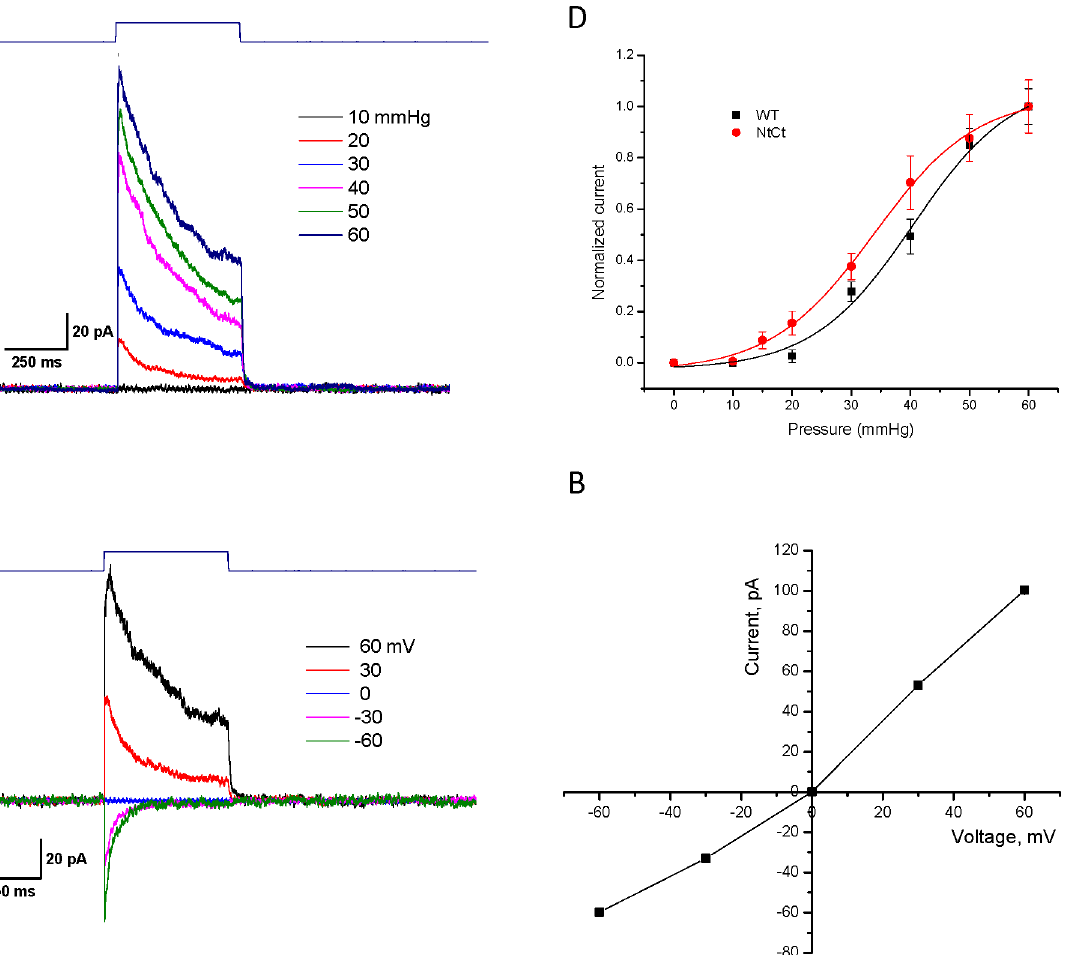
Fig 4. PIEZO1 split protein produces currents from outside-out patches. Panel A show that by increasing pressure on outside-out patches is correlated with increasing current. Panel B is a Boltzmann plot of current as a function of increasing pressure (n = 6, error bars are the S.D). The slope was approximately 8.6 mmHg -1 and P 1/2 = 34 mmHg, close to wild type values of 8.1 mmHg -1 and 42 mmHg, respectively. Panel C is the current at the indicated voltages and Panel D is a plot of the IV curve showing that the reversal potential for the outside-out patch was ~ 0